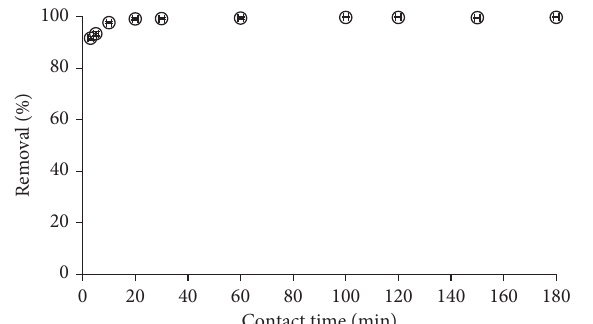
Figure 4: The effect of contact time on RhB removal using M 1 material (C i (RhB) � 10 − 5 M, pH 4, and adsorbent dosage